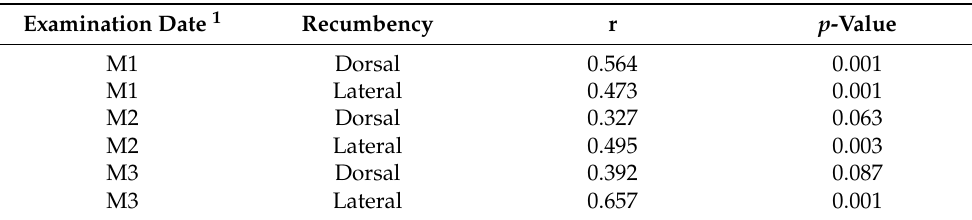
Figure 2. Magnification of an extended ventrodorsal view of both hip joints and the lumbosacral region of a Rottweiler ( a ) at the age of 18 weeks and ( b ) at the age of 52 weeks. The joint was graded as HD B/A (right/left side) on first examination. However, the final grading was HD C/B (right/left side). The dog also suffers from a lumbosacral transitional vertebra. Table 4. Correlation coefficients (r) and p -values of the Ortolani test with the reduction angle at three examination times.